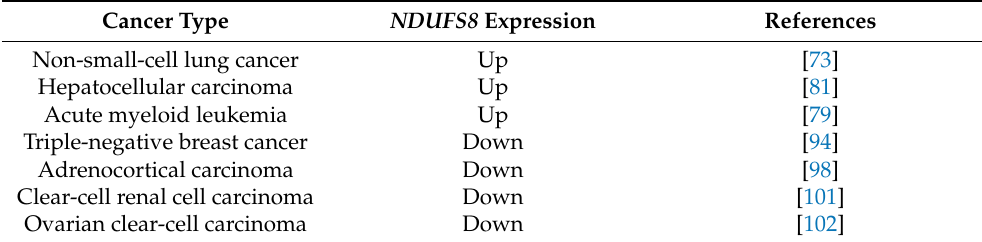
Table 3. NDUFS8 expression in different types of